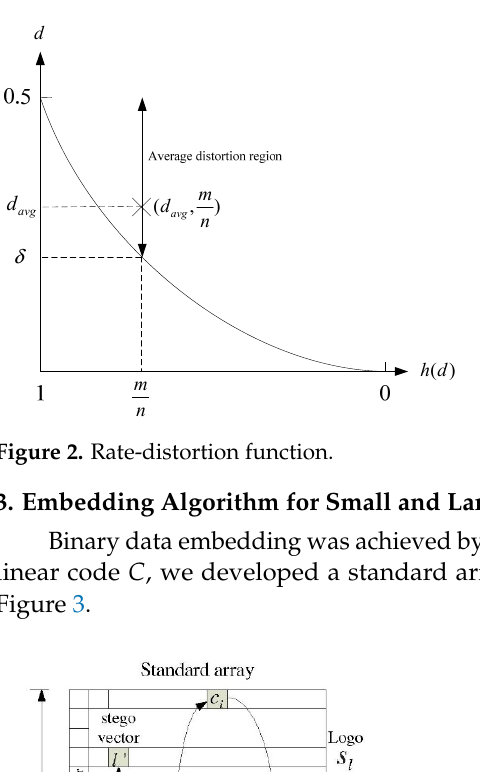
Figure 2. Rate-distortion function.